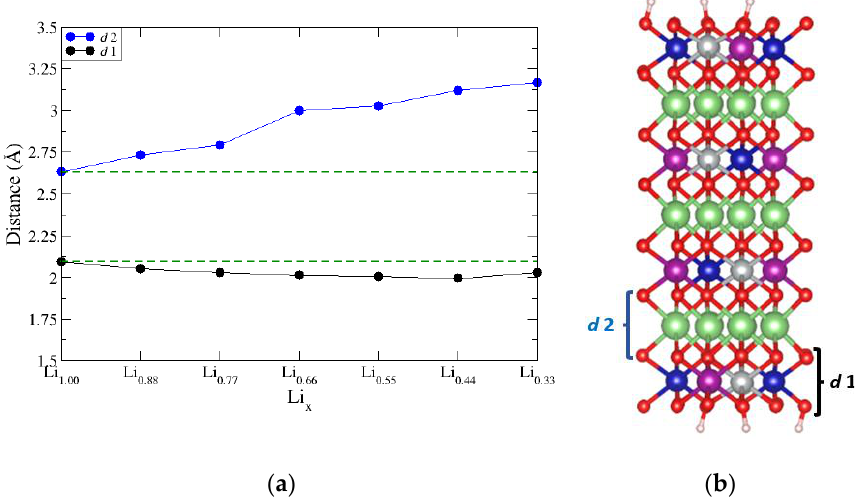
Figure 5. ( a ) O – M – O ( d 1 ) and O – Li – O layer spacings ( d 2 ) tracked across the charge cycle. ( b ) Layered NMC structural model indicating O – M – O layer in black and O – Li – O layer in blue.